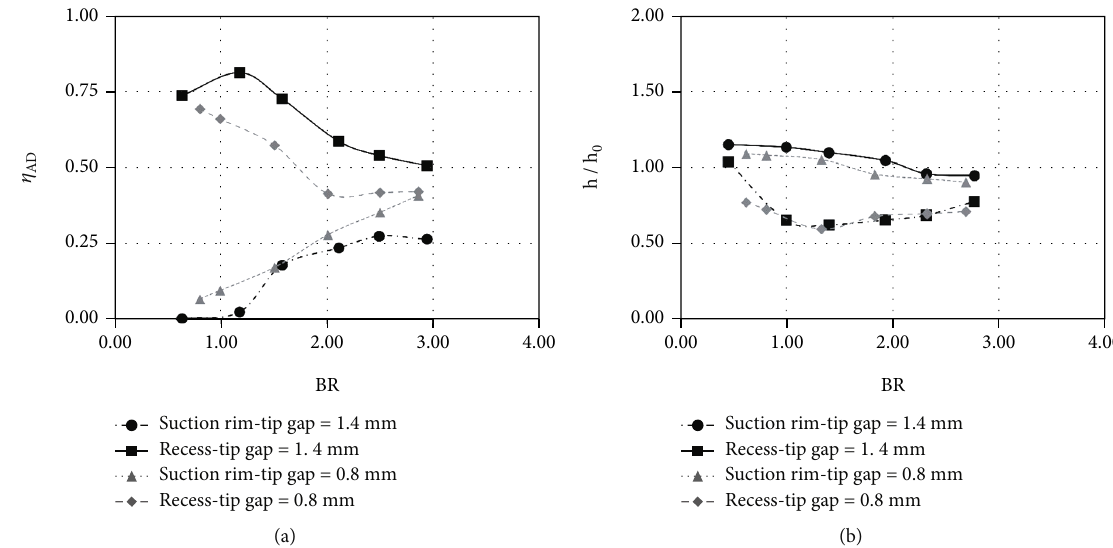
Figure 13: Area-averaged data variation for the A1 blade fi lm cooling for di ff erent blowing ratios and tip gaps. (a) Adiabatic fi lm cooling e ff ectiveness. (b) Heat transfer coe ffi cient